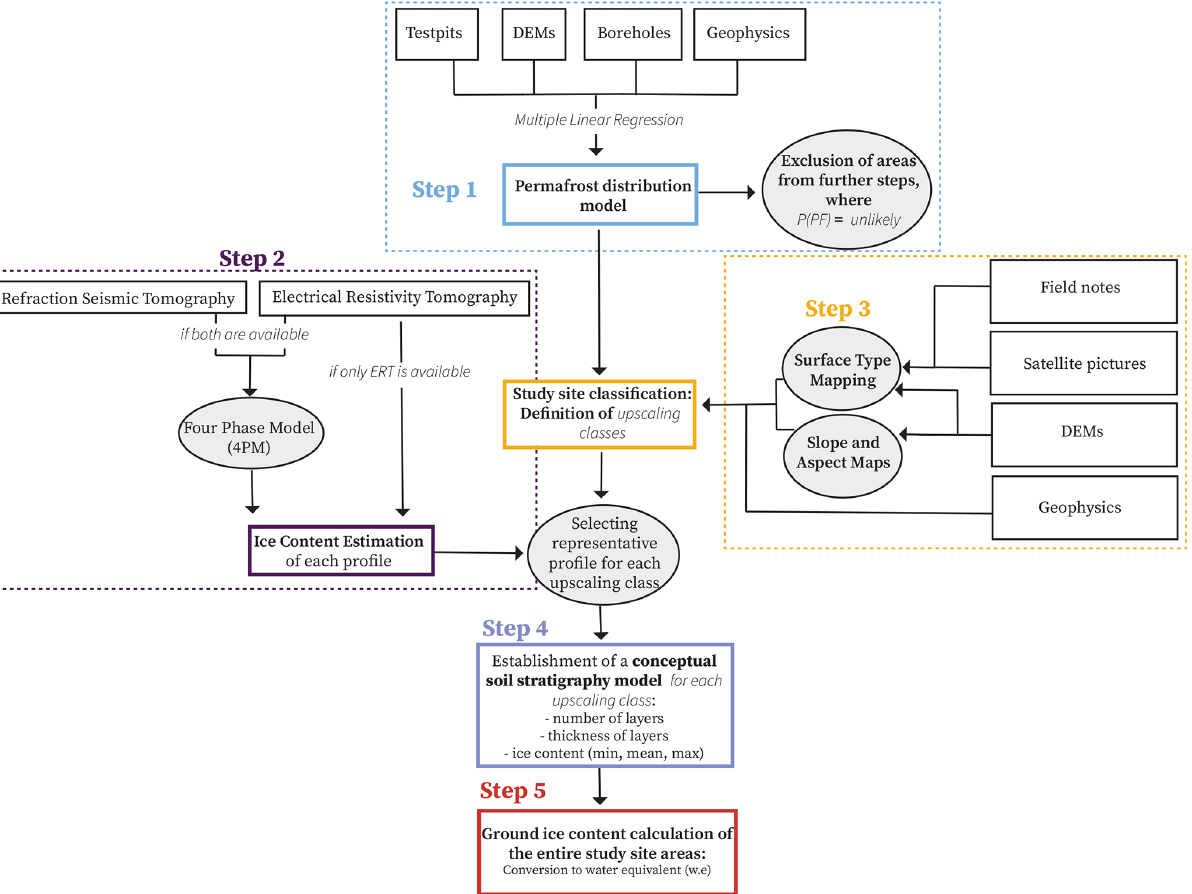
Figure 2. Workflow of the upscaling strategy used in this study. In step 1, we create a simple permafrost distribution model to exclude areas with low permafrost probability from further processing. Then, we use geophysical data and, where applicable, model the ground ice content using the 4PM (step 2). Then, in step 3, we define upscaling classes using information from different sources such as aspect and slope maps derived from DEMs, field notes, and observations. In step 4, a conceptual soil stratigraphy model is established using the geophysical results as input for subsurface layers and corresponding ice contents for each upscaling class, which serves as the basis for the upscaling of the ice content to the catchment scale (step